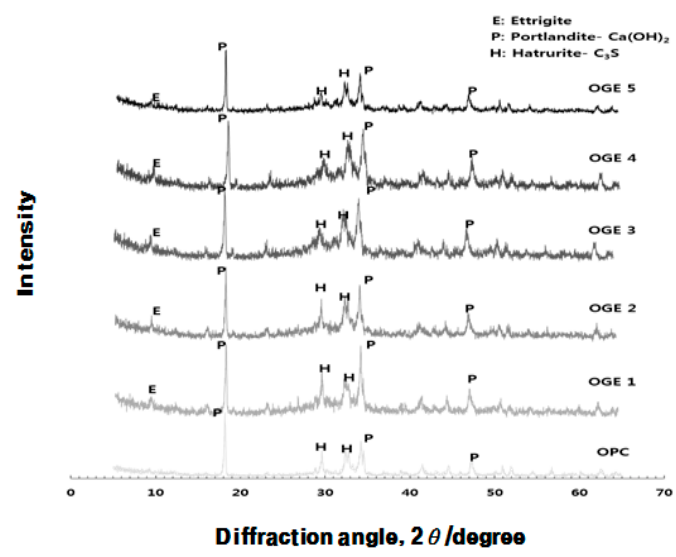
Figure 11. Quantitative analysis of the crystal structure of ESA at different burning temperatures.